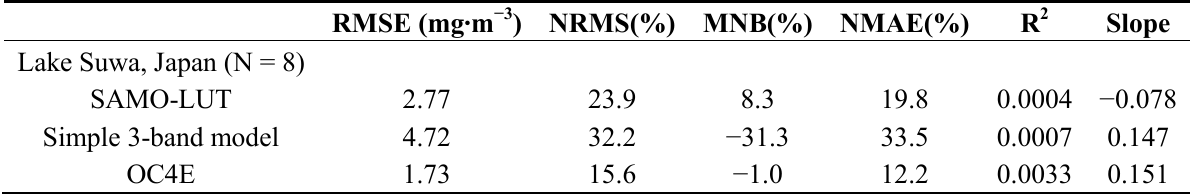
Table 5. Performance of the SAMO-LUT, Simple 3-band Model and OC4E for the estimation of Chl- a in Lake Suwa,